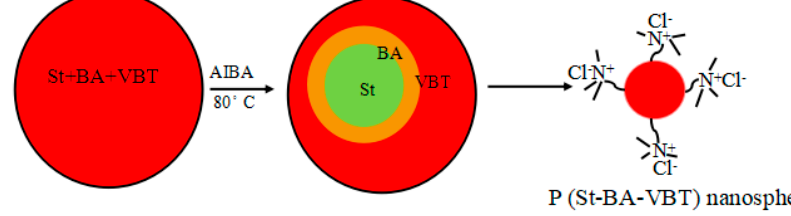
Figure 2. The polymerization for preparing the cationic P(St-BA-VBT) nanospheres.